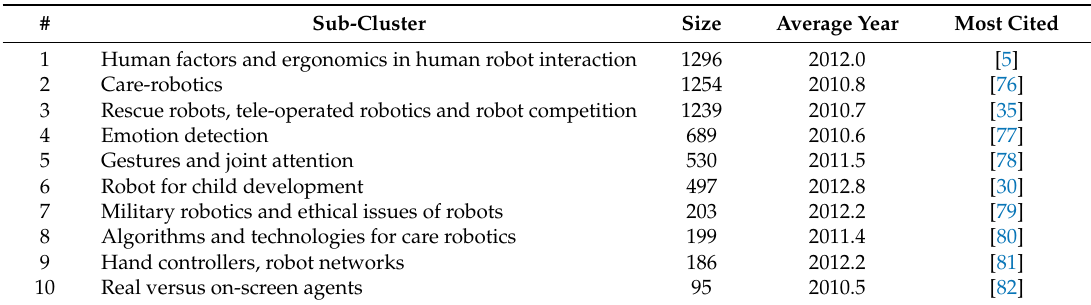
Table A1. Sub-clusters of human-robot interaction